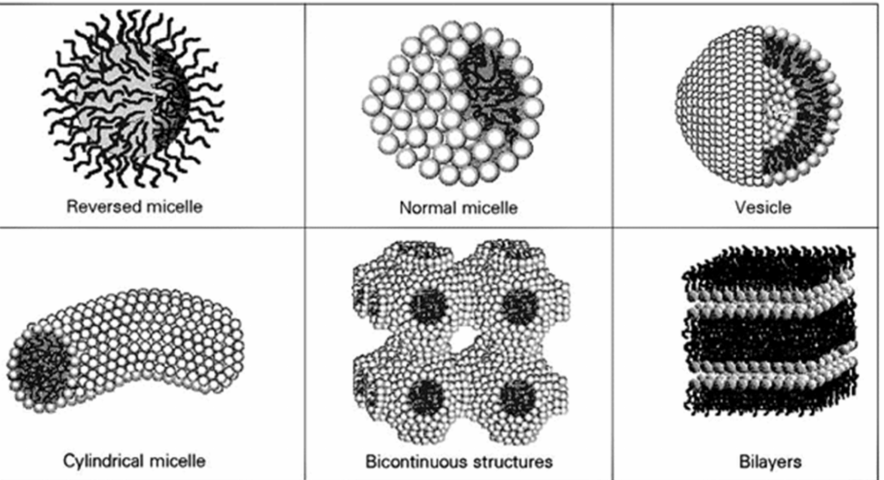
Figure 2. Most common self-assembly structures of amphiphilic molecules, including micelle, vesicle, bilayer, and bicontinuous phases. Reproduced from Florenzano et al., 1997 [30] (work licensed